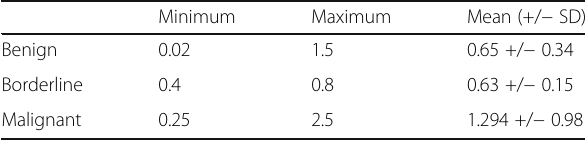
Table 8 The mean values of the choline/creatine ratio